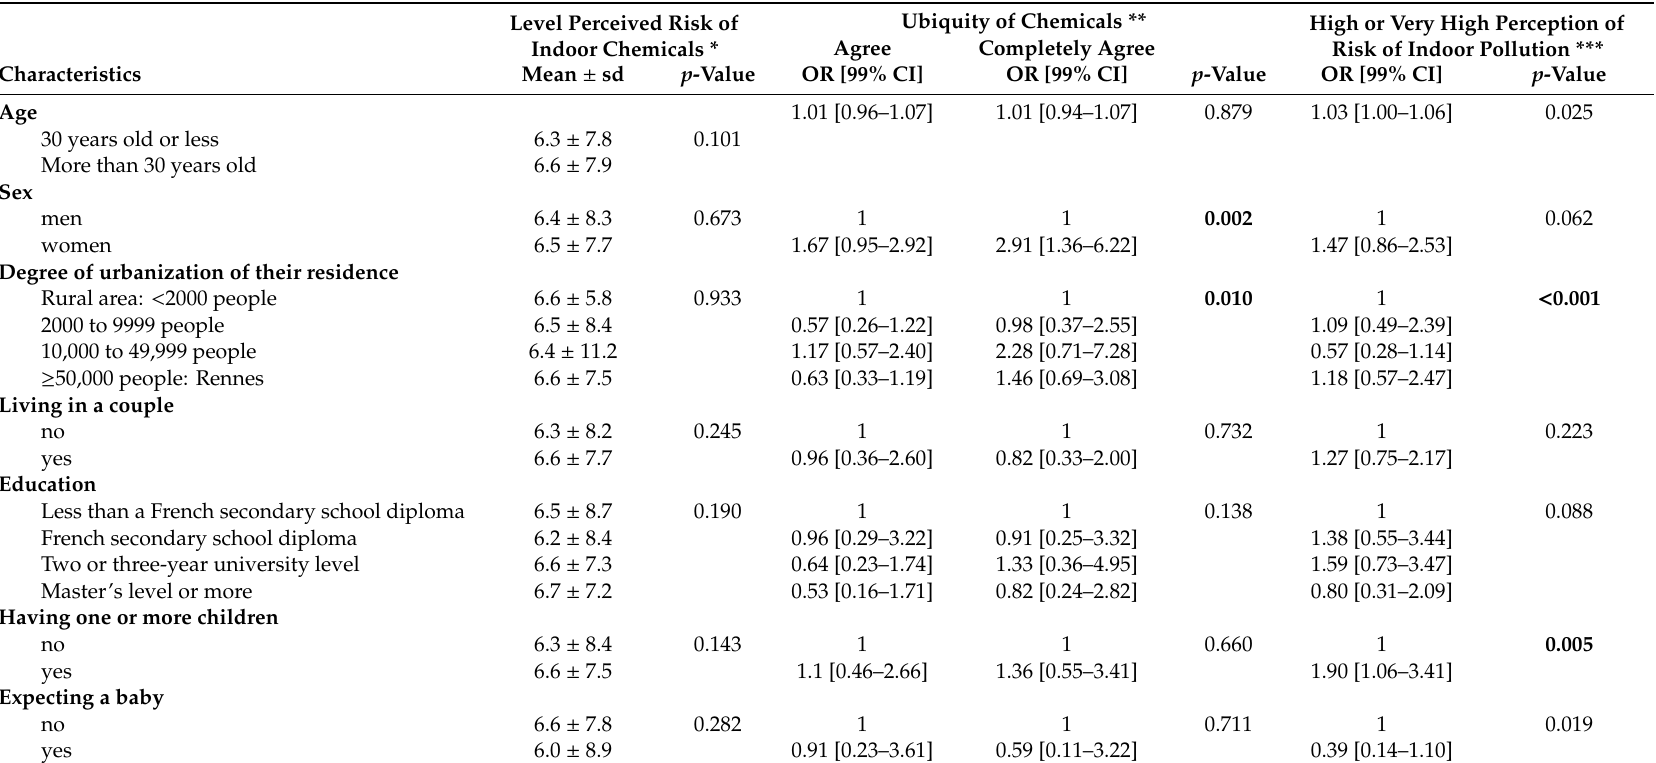
Table 3. Perceptions according to socio-demographic characteristics ( n =